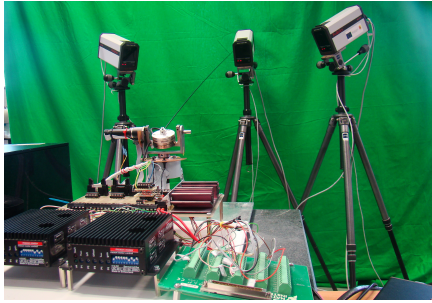
Figure 5. Photograph of the sensing antenna.